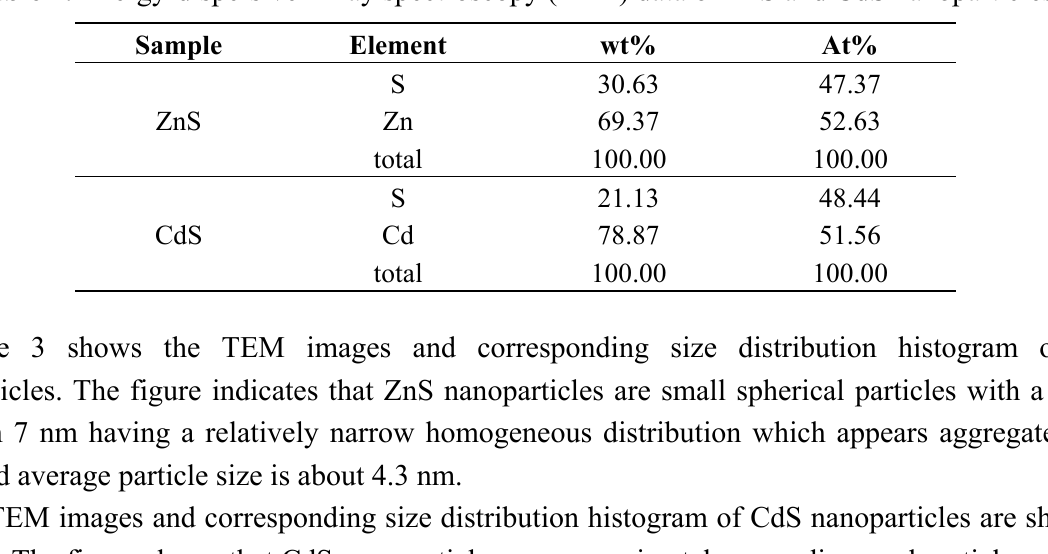
Table 1. Energy-dispersive X-ray spectroscopy (EDX) data of ZnS and CdS